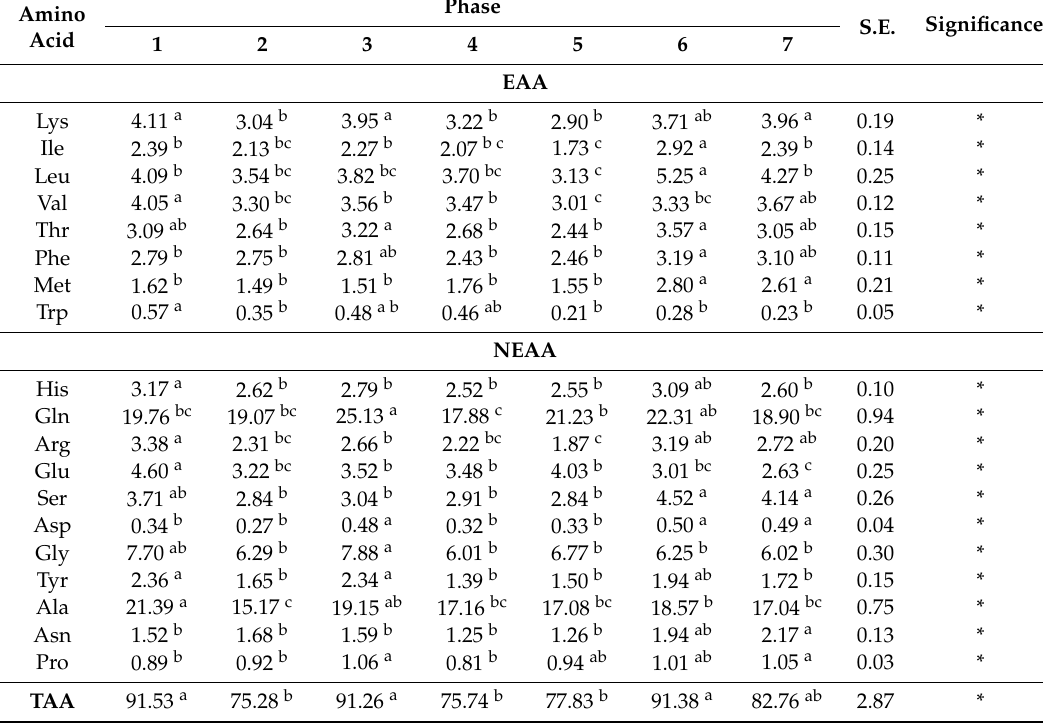
Table 3. The amino acid content of longissimus dorsi muscle of Liangshan pig (mg / 100g). Amino Acid